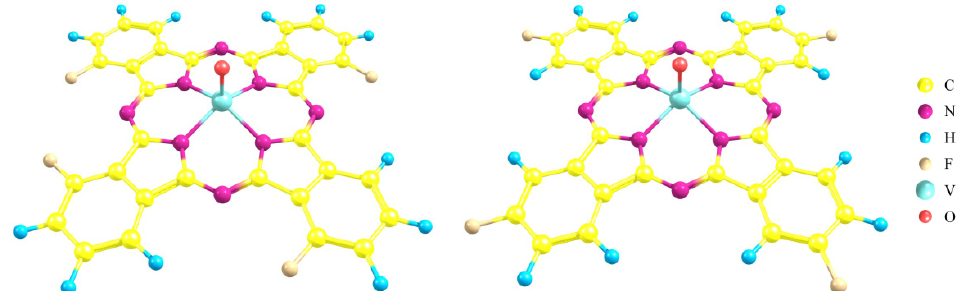
Figure 1. Structure of tetrafluorosubstituted metal phthalocyanines with F-substituents in non-peripheral (MPcF 4 -np, left ) and peripheral (MPcF 4 -p, right ) positions.